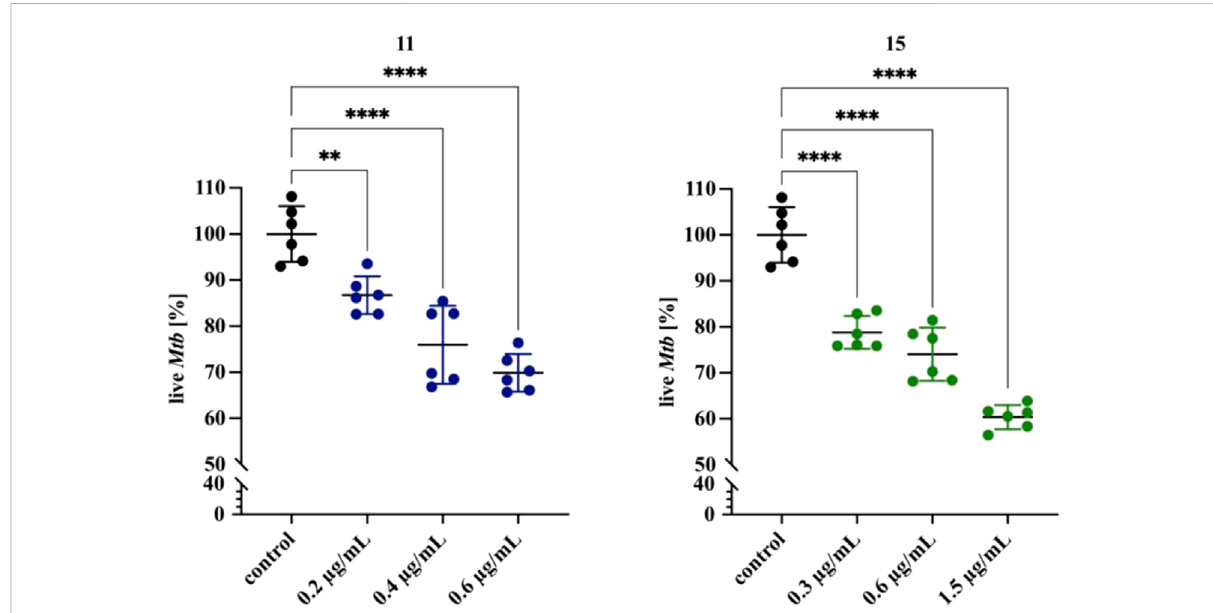
FIGURE 2 Effects of compounds 11 and 15 on mature bio fi lms composed of M. tuberculosis. Error bars indicate the standard error of the mean (SD). ** depictsthevaluewithsigni fi cantdifferencesatp=0.0027,****depictsthevalueswithsigni fi cantdifferencesatp < 0.0001.Datawerecomparedusing one-way ANOVA followed by Dunnett ’ s test. No compound control is represented by black dots. Blue and green dots represent compound 11 and 15, respectively. The concentrations of compounds are depicted at X-axis. The statistical analysis was done using SigmaStat v. 4.0. The graph was prepared using GraphPad Prism 9 version 9.3.1 (350).